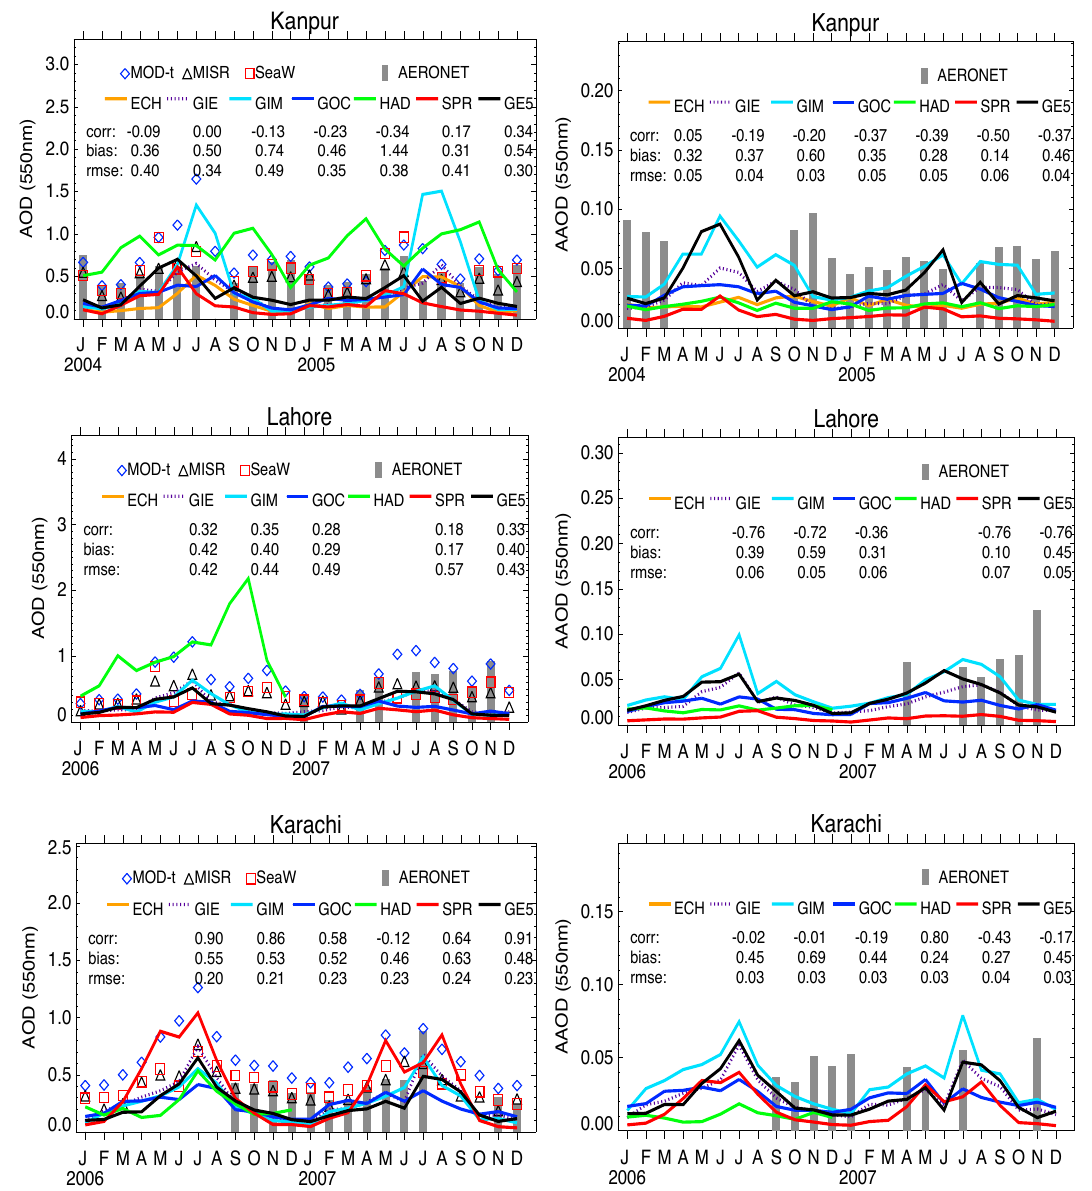
Figure 5. Monthly mean AOD (left column) and AAOD (right column) at three AERONET stations in South Asia. The gray bar rep- resents data from AERONET, the thin lines represent results from seven models, and symbols represent the data from three satellite re- trievals. On each panel corr is correlation coefficient of a model with AERONET; bias is relative mean bias, i.e., (cid:54) (AOD_MODEL i )/ (cid:54) (AOD_AERONET i ); and RMSE is root mean square error relative to AERONET.